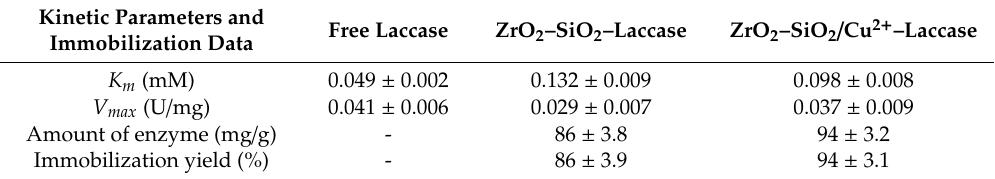
Table 2. Kinetic parameters of free and immobilized enzyme, amount of immobilized enzyme and immobilization